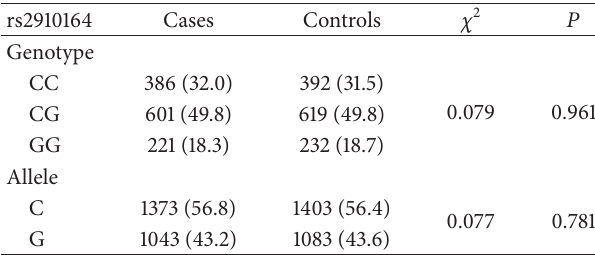
Table 2: Genotype and allele frequencies of the cases and